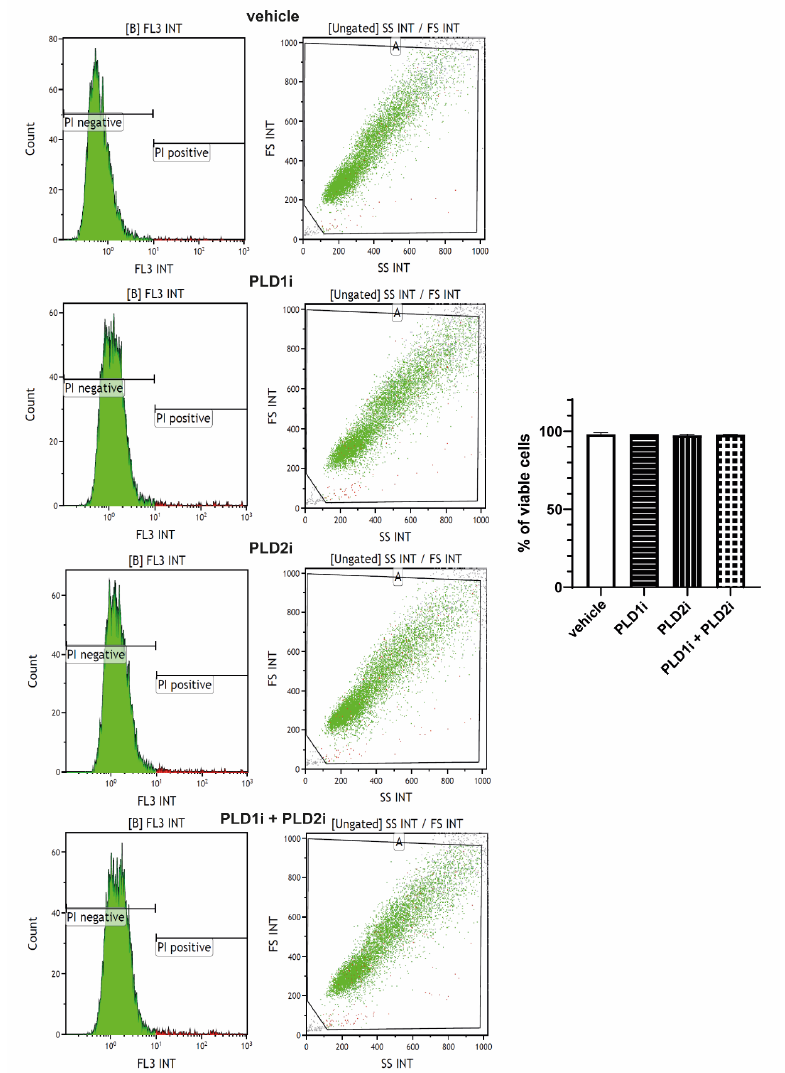
Figure 4. Effect of PLDi on viability of ABC cells. Confluent ABC cells were treated for 1 h with vehicle (0.025% DMSO), PLD1i (5 μM), PLD2i (5 μM) , or their combination (PLD1i and PLD2i, 5 μM) ; 16 h later, cells were labeled with propidium iodide (PI) (see Materials and Methods) for flow cytometry analysis. After excluding cell debris and oublets by proper gating, cells were gated between PI positive (not viable) and PI negative (viable). Ten thousand events were collected per treated sample. Data were analyzed using Kaluza Analysis Software (Beckman Coulter, Brea, CA, USA).